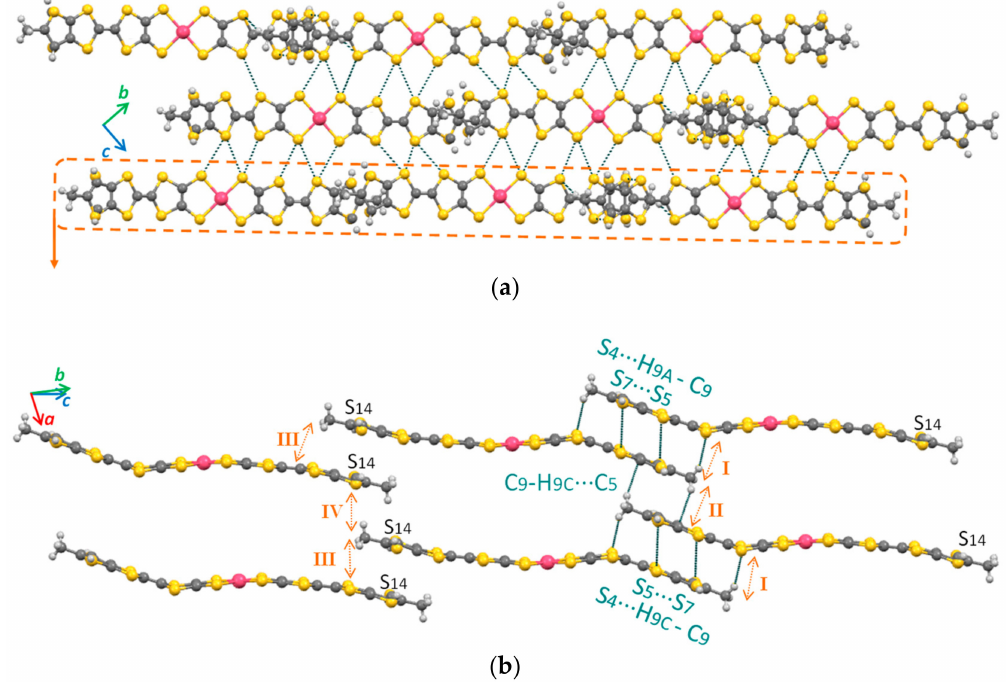
Figure 3. Anions in the crystal structure of ( n -Bu 4 N)[Au( α -mtdt) 2 ] ( 3 ): ( a ) view perpendicular to one anionic layer with side-by-side contacts; ( b ) view perpendicular to anionic chains with thiophenic ring contacts in a chain and between different layers with mean plane distances of 3.485 Å ( I ), 3.588 Å ( II ), 3.869 Å ( III ) and 3.674 Å ( IV